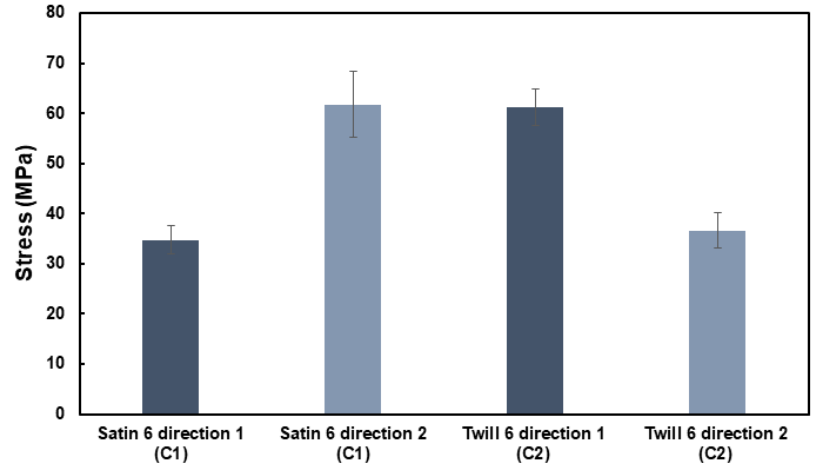
Figure 11. The flexural strength of the two composite materials.